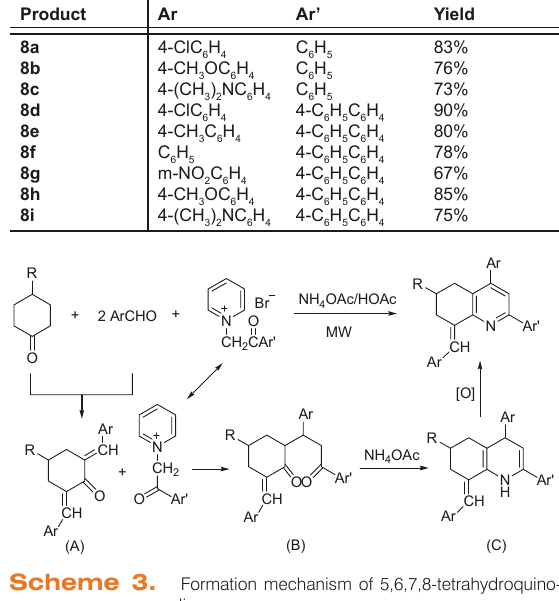
Table 2. Preparation of 5,6,7,8-tetrahydroquinoline derivatives. Product